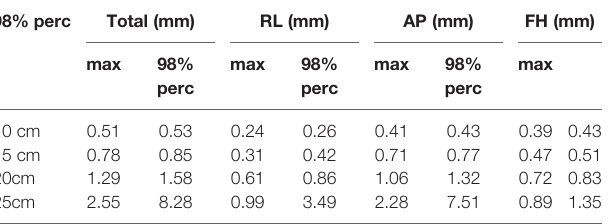
TABLE 4 | Distortion of the commercial